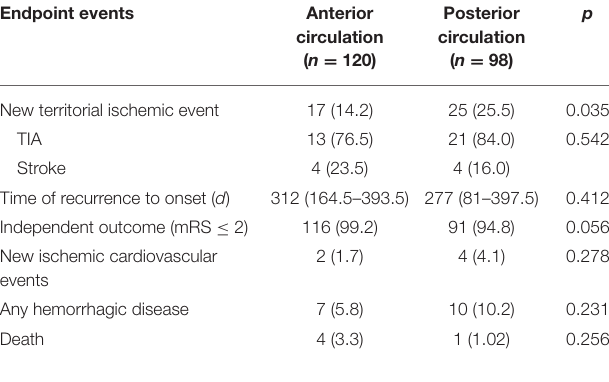
TABLE 3 | Comparison of the 1-year outcome in both groups.